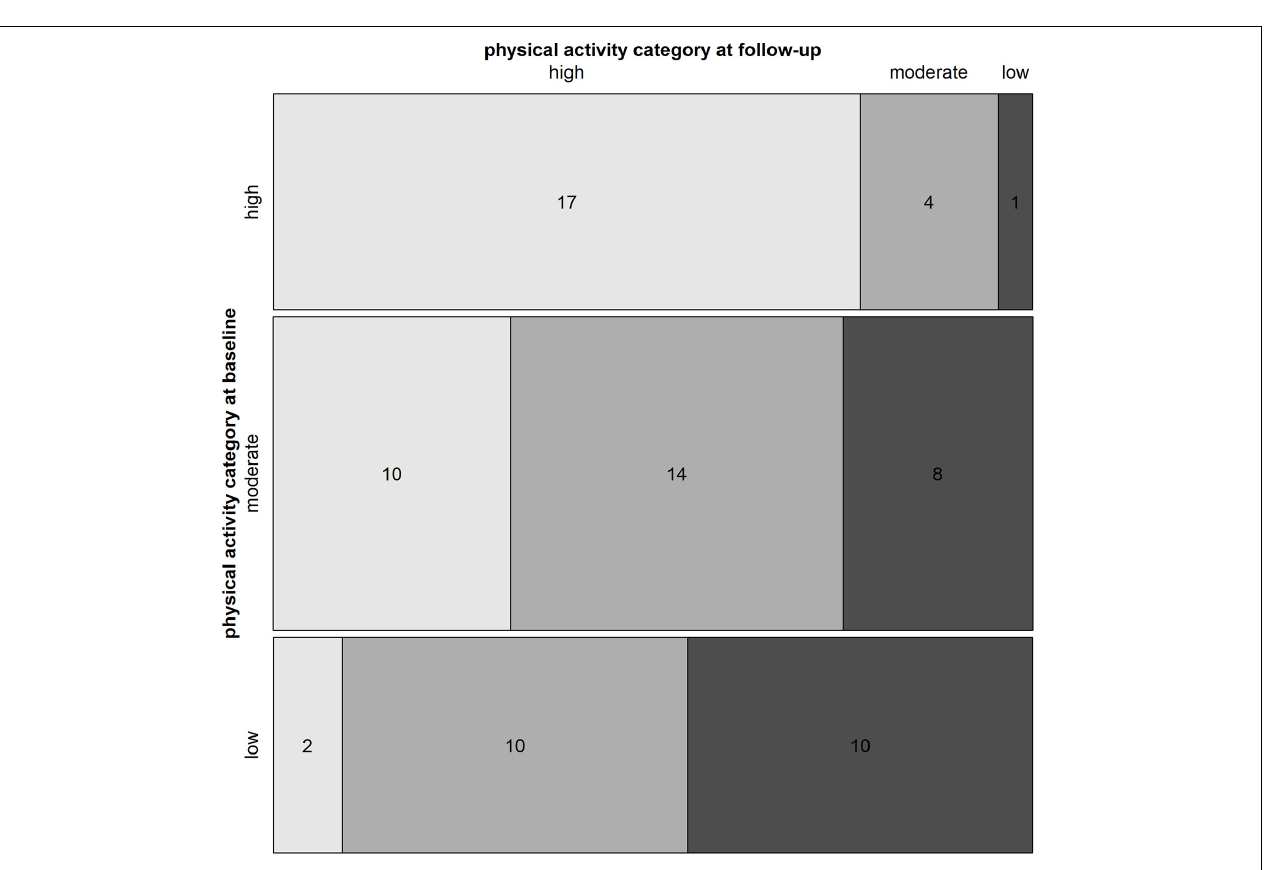
Frontiers in Psychology |